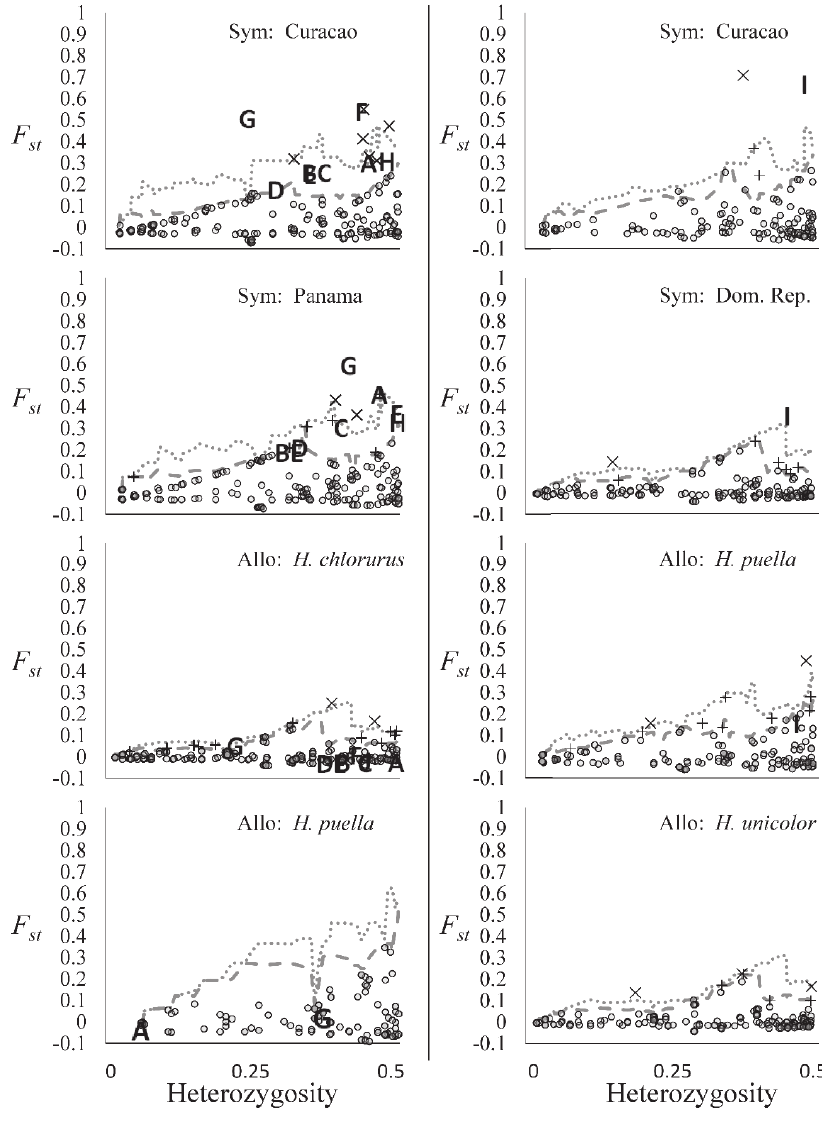
Figure 3. F ST values for AFLP loci used for repeated outlier loci detection. Left hand plots represent pairwise comparisons for populations of H. chlorurus and H. puella in Curacao and Panama. Right hand plots represent pairwise comparisons for populations of H. puella and H. unicolor in Curacao and Panama. ‘‘Sym’’ refers to sympatric comparisons of the two morphotypes concerned (followed by the location), ‘‘allo’’ refers to allopatric comparisons of the two locations concerned (followed by the morphotype). Letters refer to loci repeated across sympatric comparisons (see Table 4 for full loci names and further details). Dashed lines represent the simulated 95% F ST level, dotted lines represent the simulated 99% F ST level. Repeated outlier comparisons that did not return any outliers repeated across sympatric comparisons are not